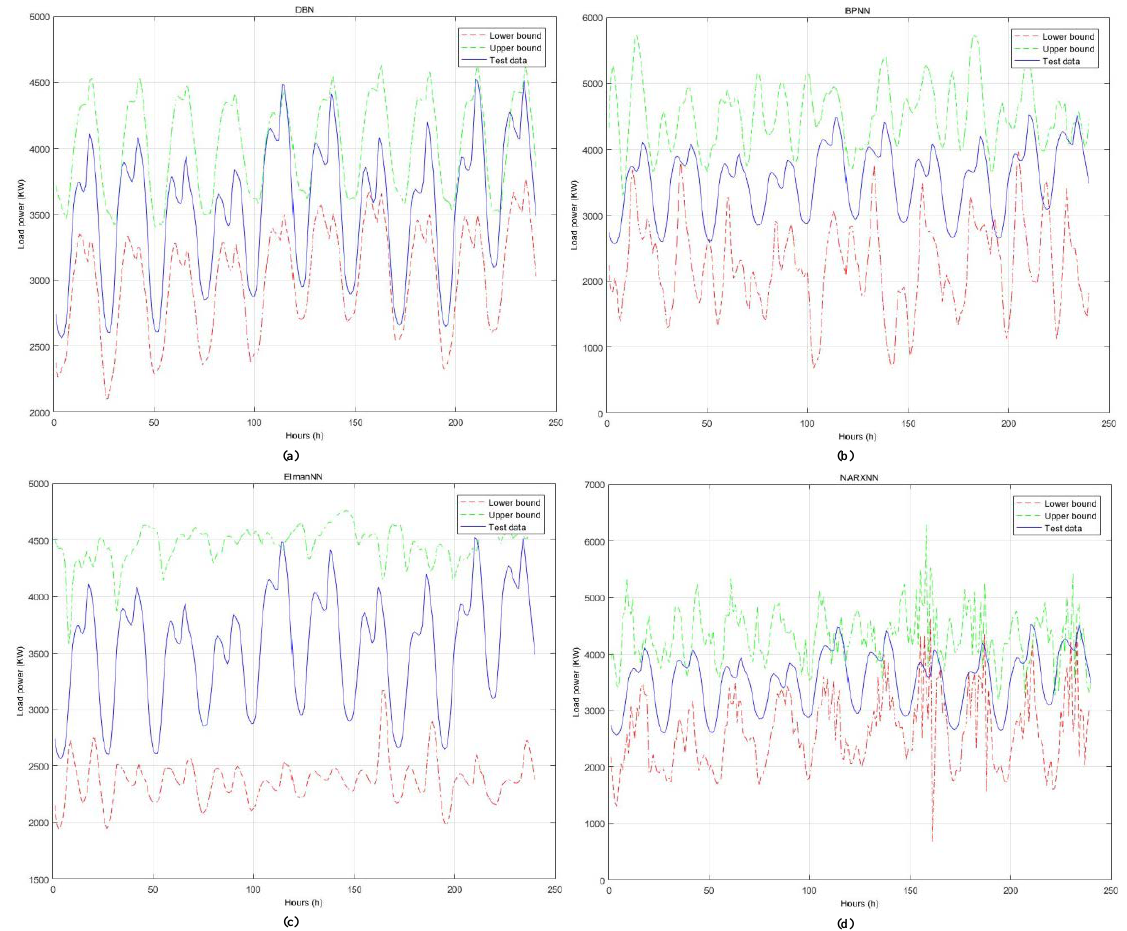
Figure 10. The construction PI of 10 continuous days by four prediction models: ( a ) DBN-based PI; ( b ) BP network neural-based PI; ( c ) Elman network neural-based PI; ( d ) NARX network neural-based PI.